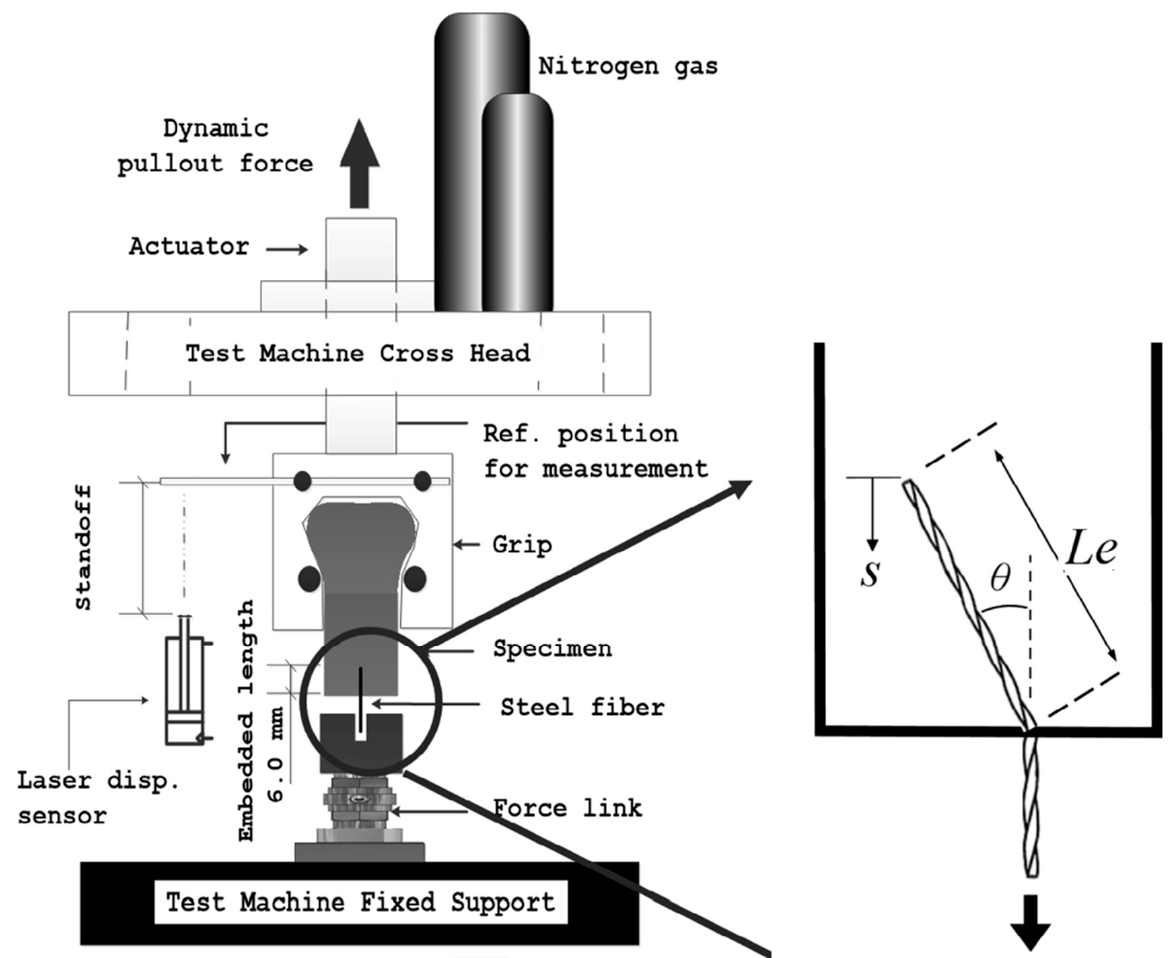
Figure 17. Schematic of inclined steel fibre pull-out test setup [26].